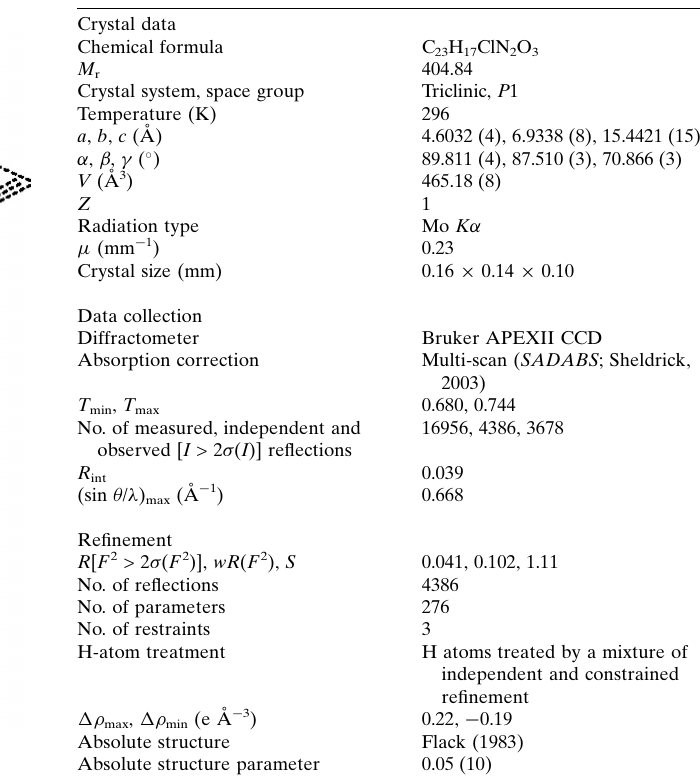
Table 2 Experimental details.